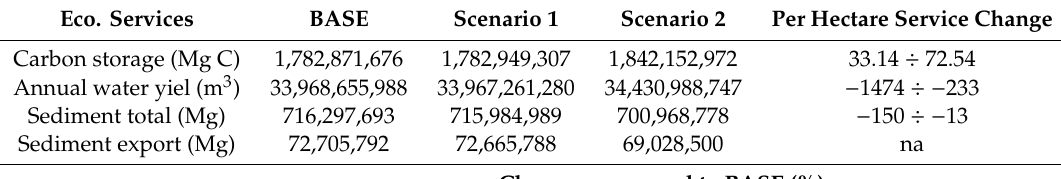
Table 8. Potential ecosystem services feedback from suggested land use land cover change.